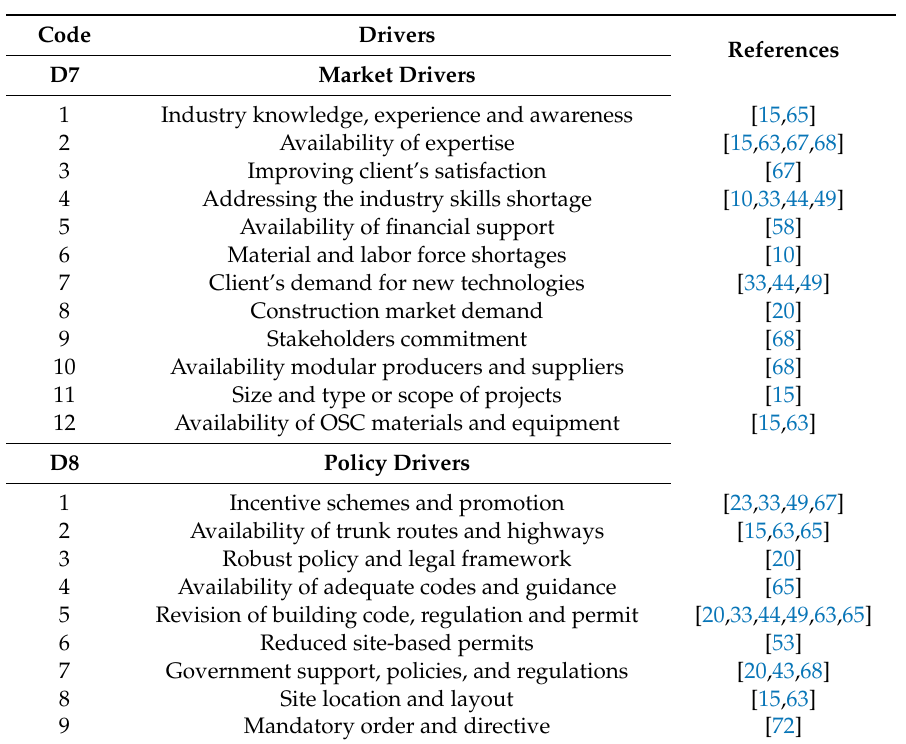
Table 3. Market and policy drivers of OSC in previous